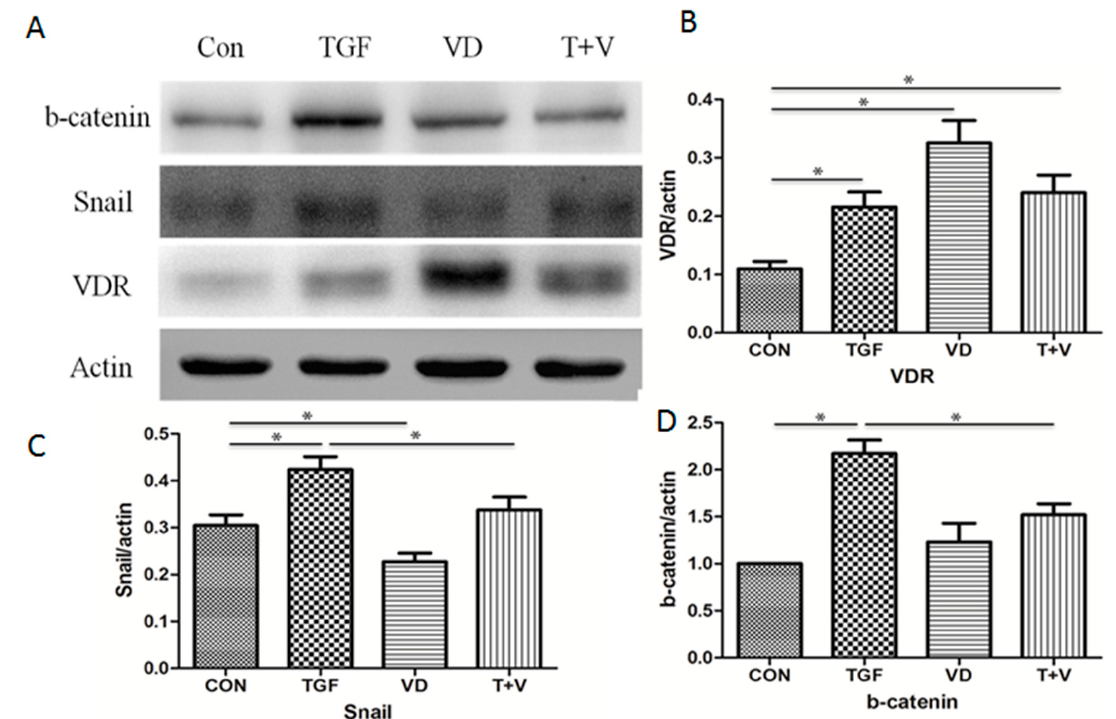
Figure 4. 1 α ,25(OH) 2 D 3 represses EMT-related transcription factors by TGF- β and increases VDR expression. A549 cells were treated with 5 ng/mL TGF- β and/or 50 nmol/L 1 α ,25(OH) 2 D 3 for 72 h. ( A ) Western blot analysis of β -catenin, Snail and VDR. β -actin served as a loading control; ( B – D ) the levels of the indicated protein were quantified with gray value (Mean ± SD, n = 3). * p < 0.05 compared with the corresponding group.